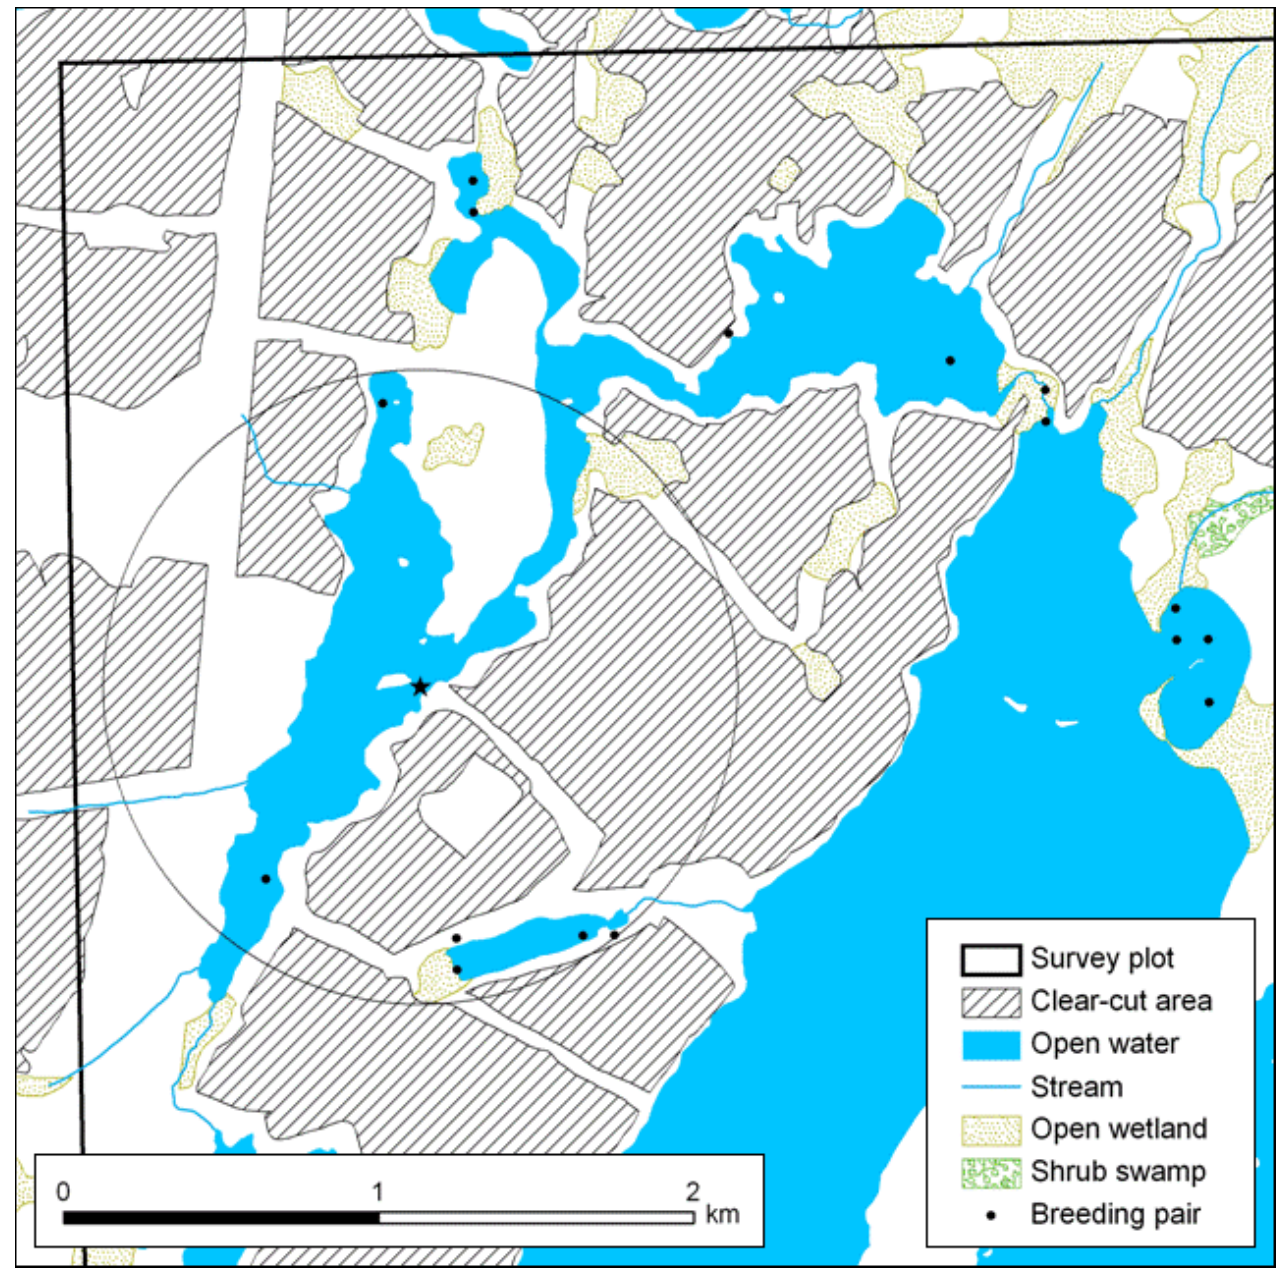
Fig. 3. Example of a harvested plot (partial) with all IBP locations of a single survey year, as well as an example of an IBP (black star) with its 1-km radius circle. For that particular IBP, the percentage of nesting habitat undisturbed by timber harvesting was 47% for ground-nesting species and 45% for cavity-nesting species (see Methods for details on definition of nesting habitat). Clear-cut areas used for these calculations are the same for pre- and post-harvest